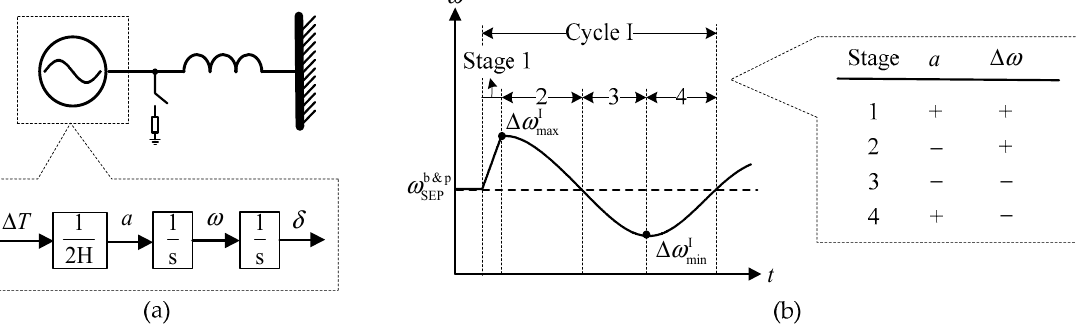
Figure 1. Schematic diagram of ( a ) the single machine infinite bus (SMIB) system and ( b ) the four-stage division criterion.